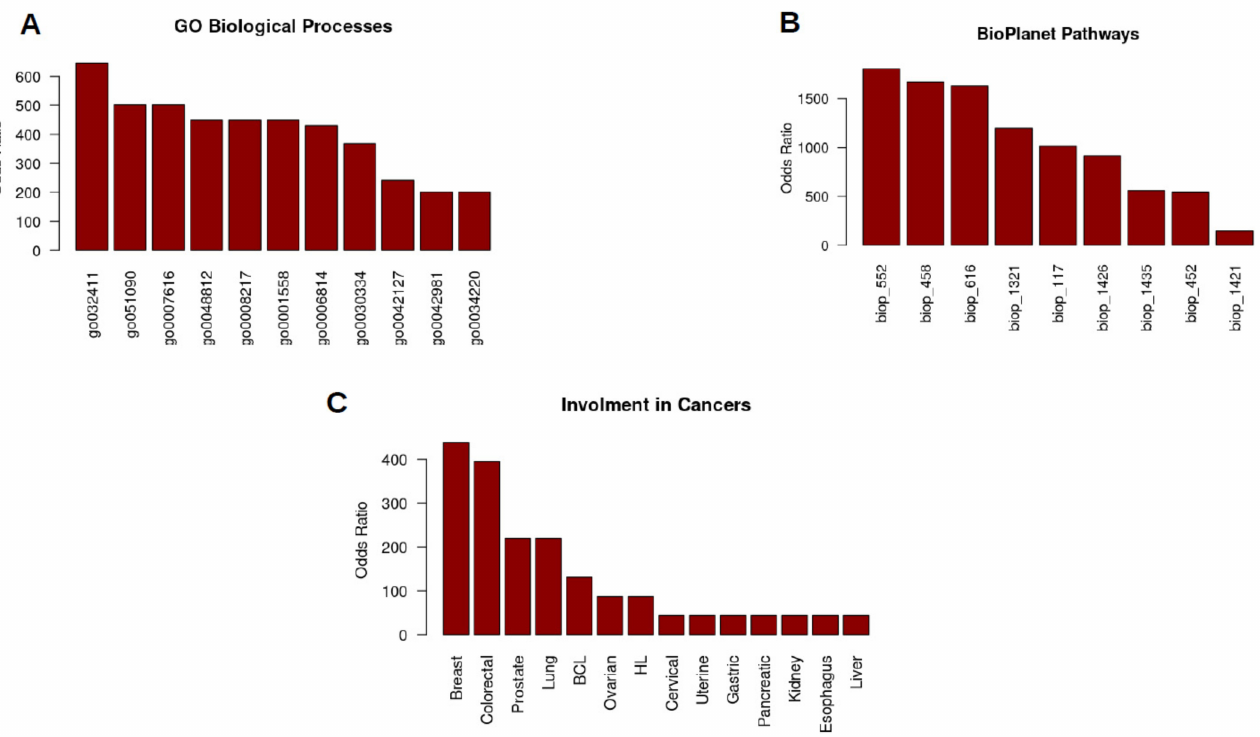
Figure 3. Involvement of SGK1 in major processes and cancers. ( A ) Most significant gene ontology bi- ological processes in which SGK1 is involved. Positive regulation of transporter activity GO:0032411, regulation of DNA-binding transcription factor activity GO:0051090, long-term memory GO:0007616, neuron projection morphogenesis GO:0048812, regulation of blood pressure GO:0008217, regulation of cell growth GO:0001558, sodium ion transport GO:0006814, regulation of cell migration GO:0030334 (cid:48) regulation of cell population proliferation GO:0042127, regulation of apoptotic process GO:0042981, ion transmembrane transport GO:0034220. ( B ) Involvement of SGK1 in most significant signaling pathways, calculated using BioPlanet data. FSH signaling pathway bioplanet_552, aldosterone- regulated sodium reabsorption, bioplanet_458, FoxO family signaling bioplanet_616, regular gluco- corticoid receptor pathway bioplanet_1321, mTOR signaling pathway bioplanet_117, interleukin-5 regulation of apoptosis bioplanet_1426, FSH regulation of apoptosis bioplanet_1435, insulin signaling pathway bioplanet_452, interleukin-2 signaling pathway, bioplanet_1421. ( C ) Most studied types of malignant diseases with a SGK1 playing certain role. Analyzed by biostatistics/bioinformatics at MAP Kinase Resource using data curated at Swiss Institute of Bioinformatics (Geneva, Switzeland) (Jonas